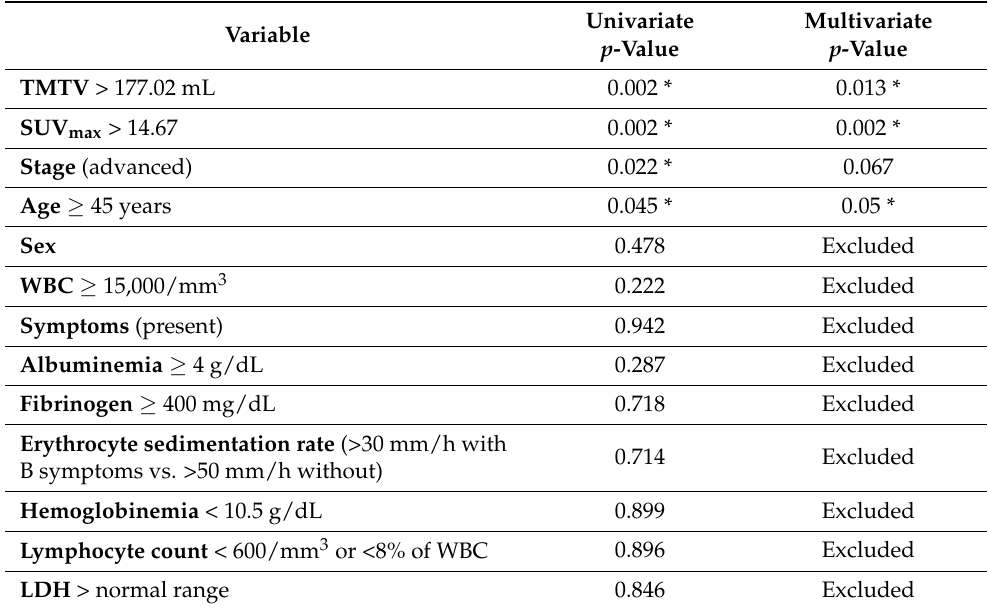
Table 3. Univariate and multivariate